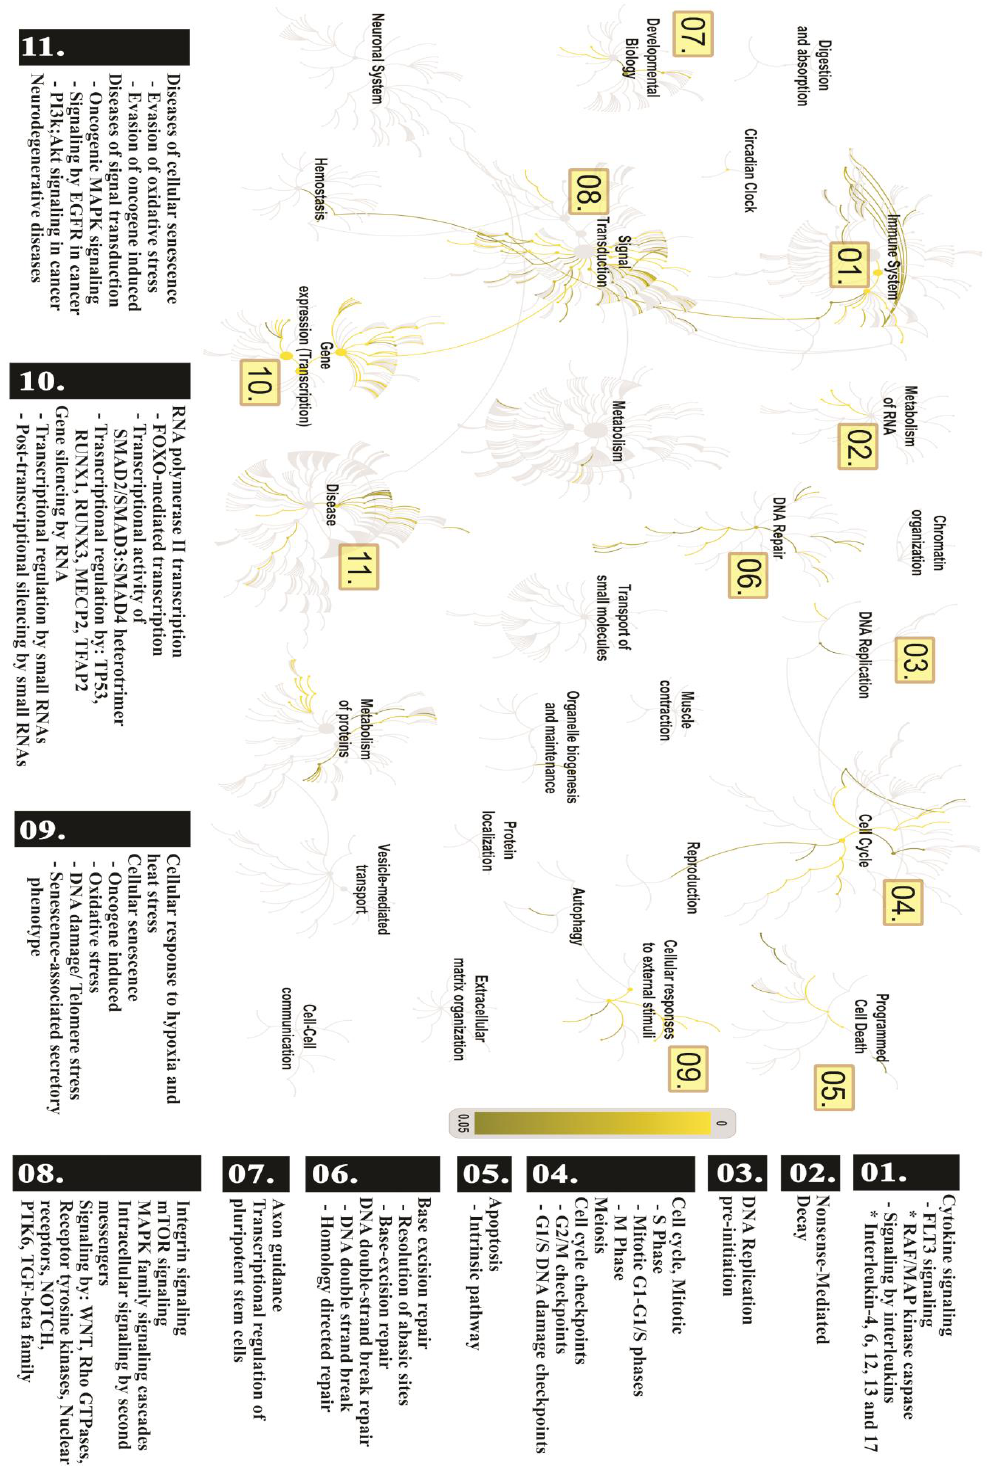
Figure 7. Genome-wide overview of the pathways analysis. Reactome pathways are arranged hierarchically. The center of each of the circular “bursts” is the root of one top-level pathway. Each step away from the center represents the next level above in the pathway hierarchy. The color code denotes the over-representation of that pathway in the input dataset. A numeric ID identifies the biological process significantly over-represented and correlated with a carcinogenic process (01–11), used to discriminate the significant main pathway involved in this process. Light grey represents pathways that are not significantly